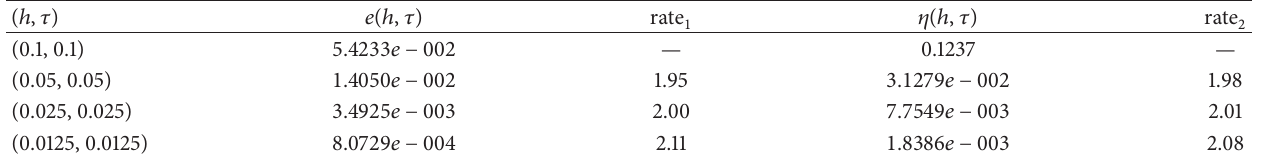
Table 2: Errors and rates of convergence for Scheme B with different ℎ and 𝜏 at time 𝑇 = 5 .